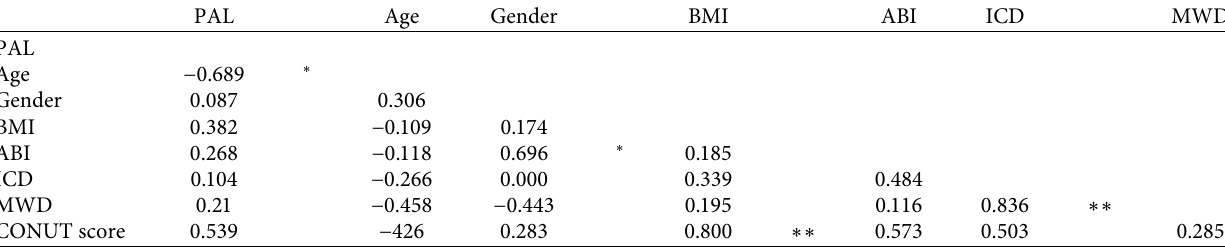
Table 3: Correlation matrix of the variables in PAD